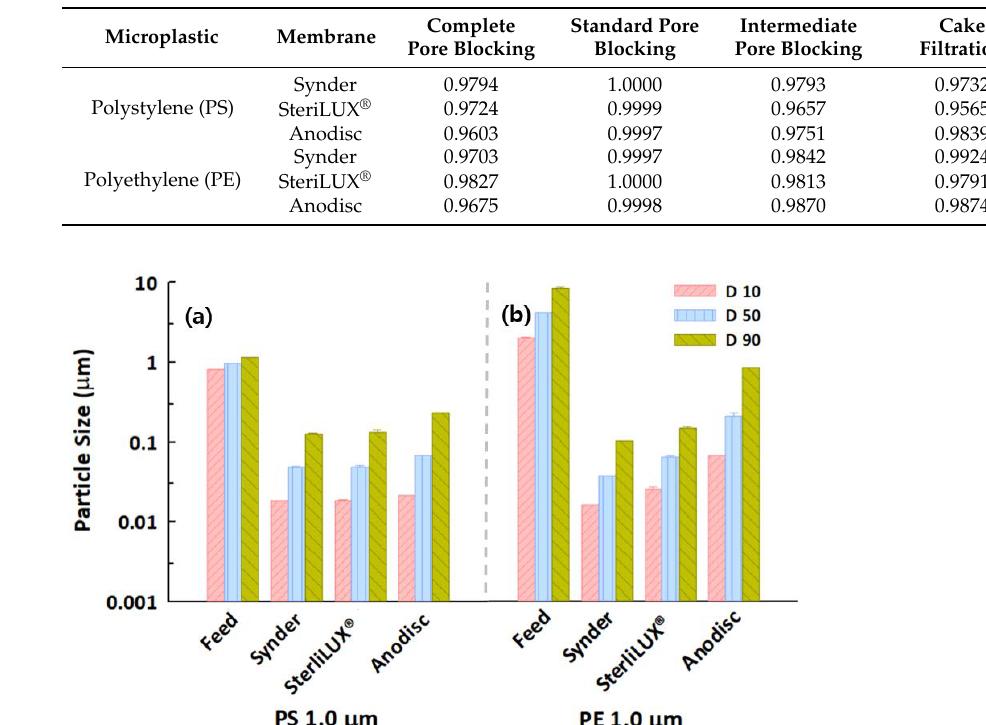
Figure 7. Particle size distribution in the feed and permeate water samples after membrane filtration for (a) 1.0 μm PS and (b) 1.0 μm PE microplastics with the same concentration.